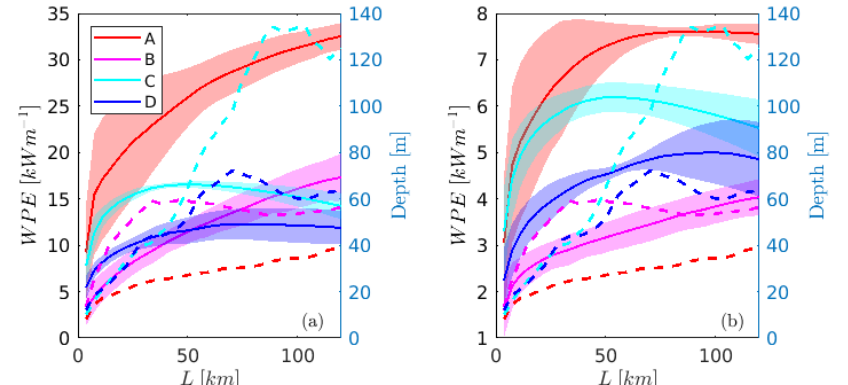
Figure 9. The WPE as function of the distance from the coast for January ( a ) and July ( b ) in the four chosen areas from Exp1. The shaded areas represent the standard deviation. The mean water depth changes with the distance from the coastline are shown as dashed